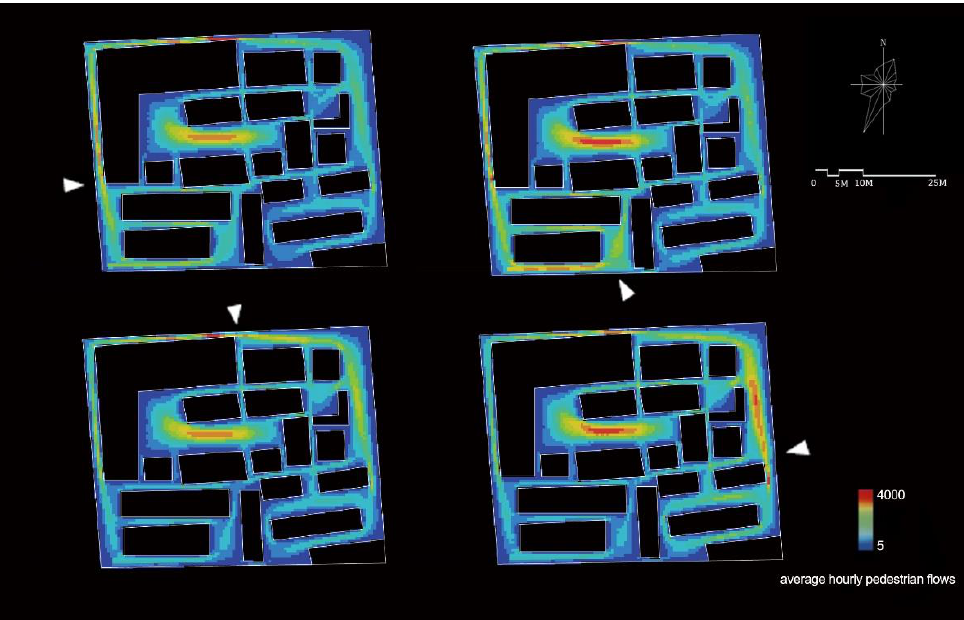
Figure 7. Pedestrian flow simulation on VGA of the highlighted block in Figure 5 (the red and the blue denote high and low tourist intensity, respectively.).